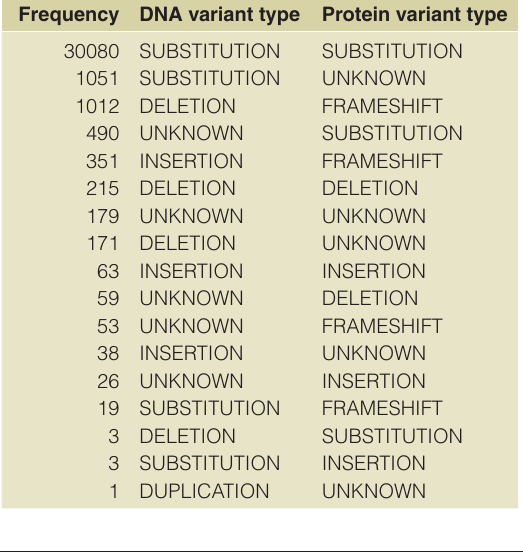
Table 18. COSMIC missing variants by the combination of variant extraction tools grouped by type, taking into account the DNA variant and the impact on the gene product. Missing variants have been annotated using SETH, thus the variant types delivered by SETH are considered.